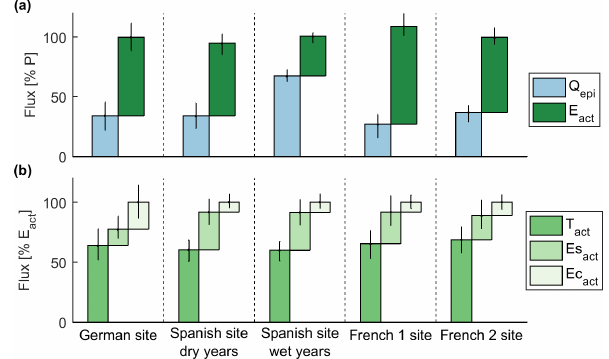
Figure 5. (a) Simulated recharge ( Q epi ) and actual ET ( E act ) ex- pressed as a percentage of total precipitation, and (b) simulated ac- tual transpiration ( T act ), actual soil evaporation (Es act ) and actual evaporation from interception (Ec act ) expressed as a percentage of E act . The figure reports the ensemble mean and 95% confidence in- tervals calculated over the behavioural simulation ensemble of the V2Karst model at the four FLUXNET sites. Simulated fluxes were evaluated over the period from 1 January 2001 to 17 December 2009 for the German site, 1 January 2006 to 31 December 2008 for the Spanish site (dry years), 1 January 2009 to 30 December 2011 for the Spanish site (wet years), 1 January 2010 to 30 December 2011 for the French 1 site and 1 April 2003 to 31 March 2009 for the French 2